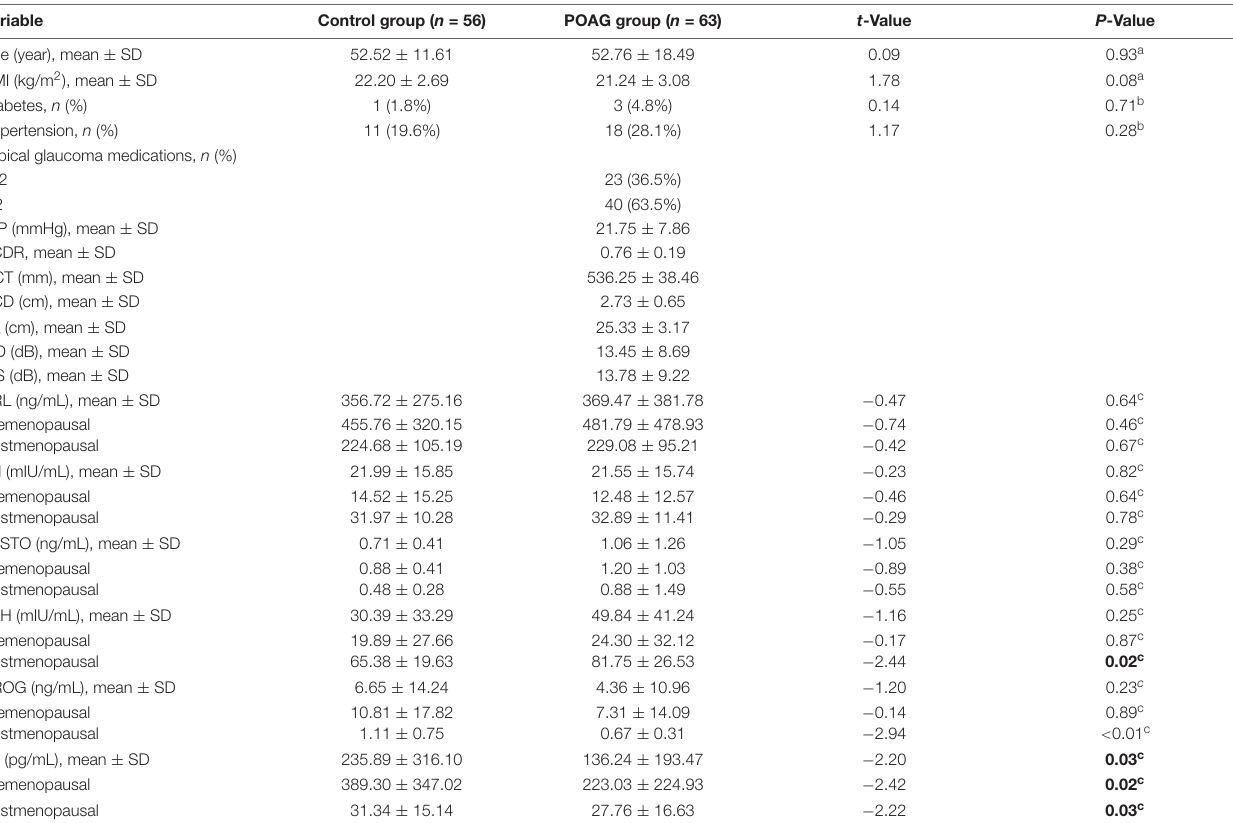
TABLE 1 | Comparison of characteristics in women with POAG and normal subjects.